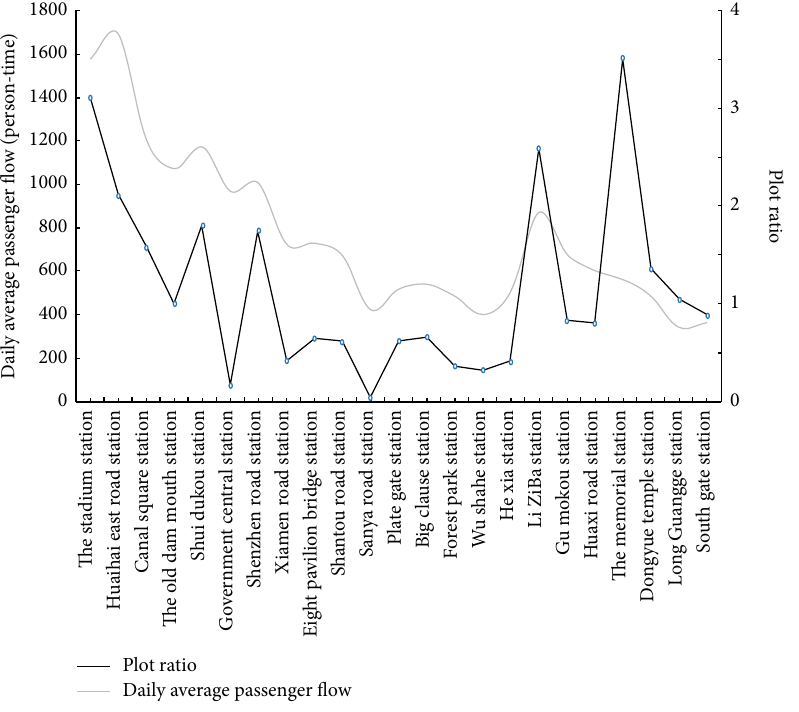
Figure 6: The impact of service level on passenger flow.